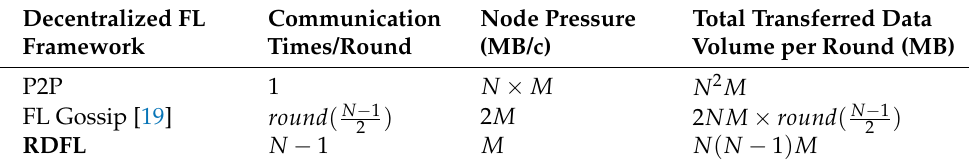
Table 1. Communication complexity